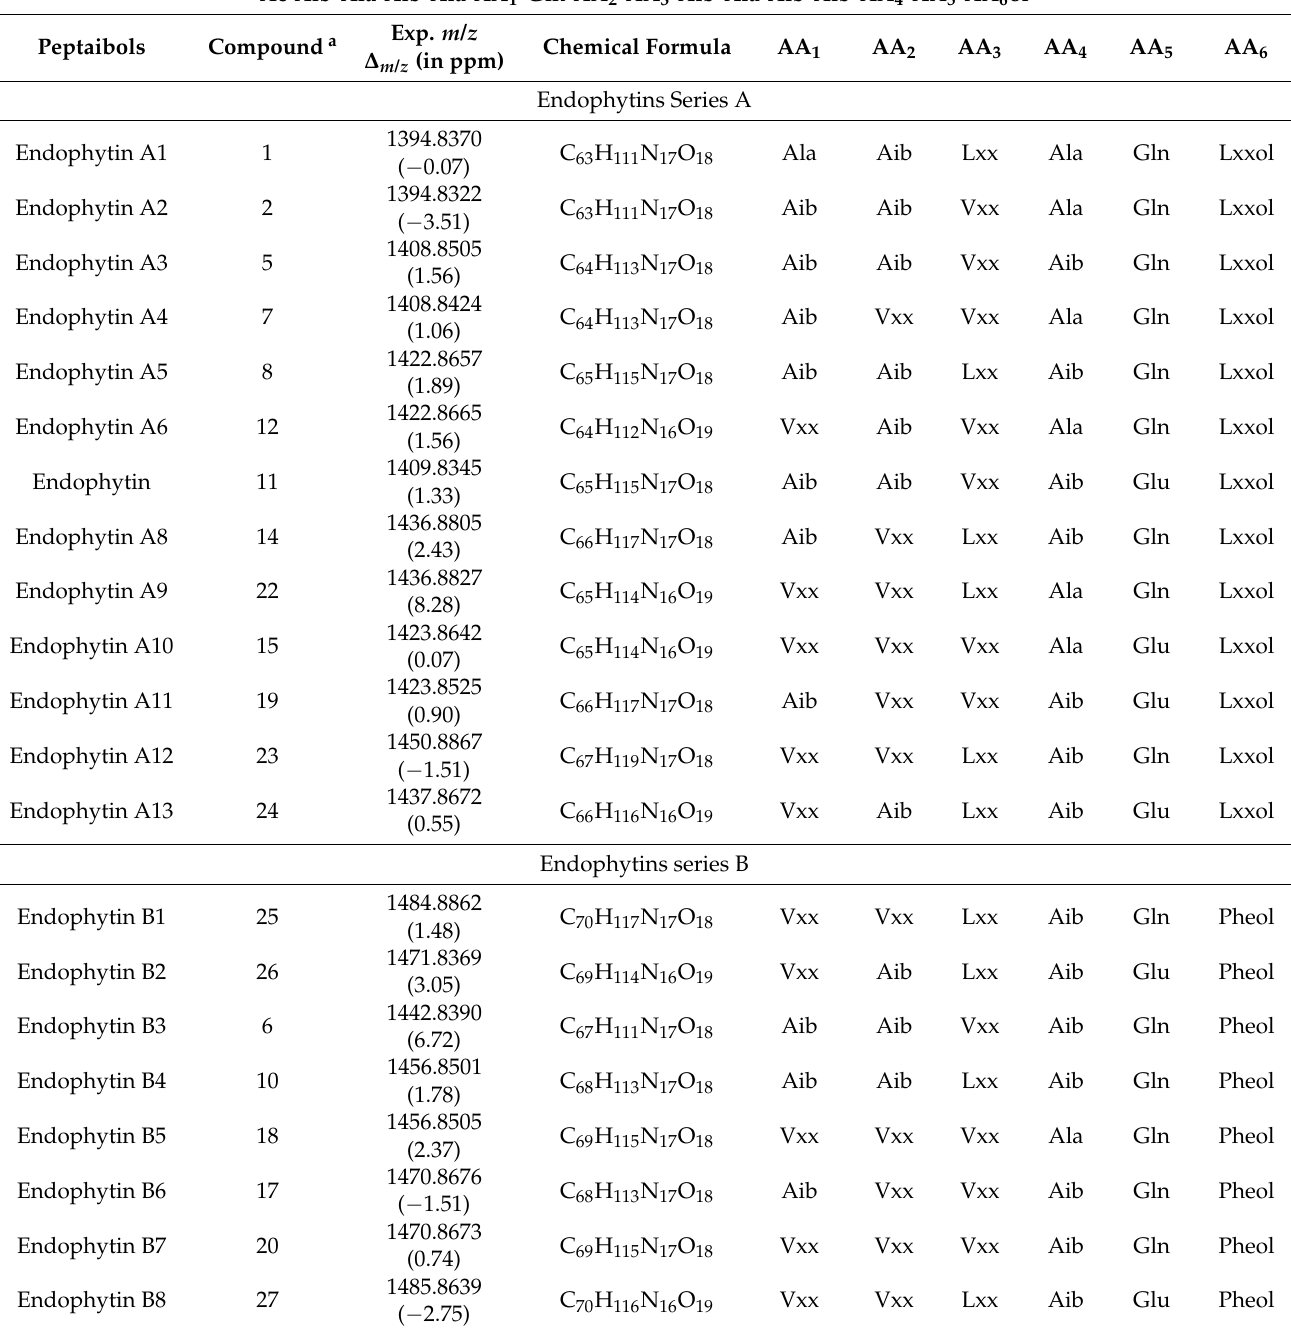
Table 1. New endophytins A1–A13 and B1–B8 produced by T. endophyticum